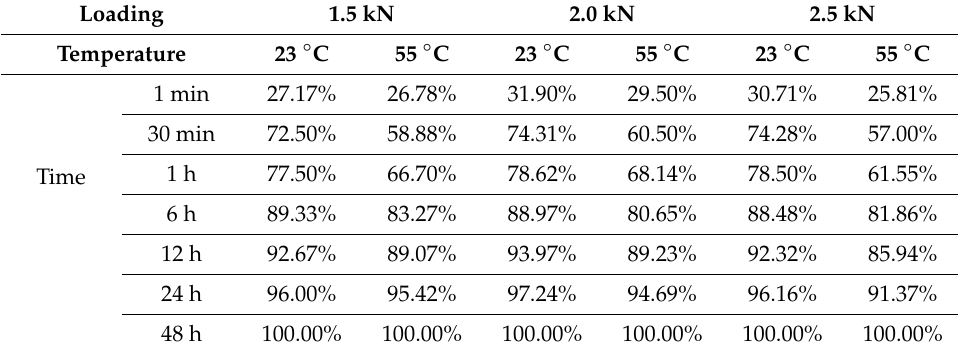
Table 4. Creep (%) of rubber materials during the creep test at di ff erent